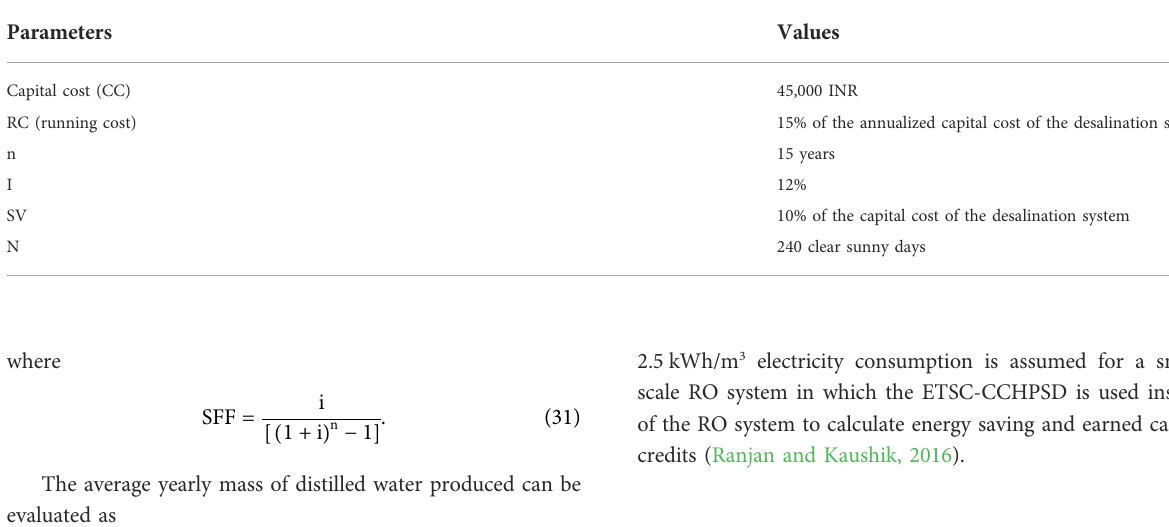
TABLE 3 Parameters for economic